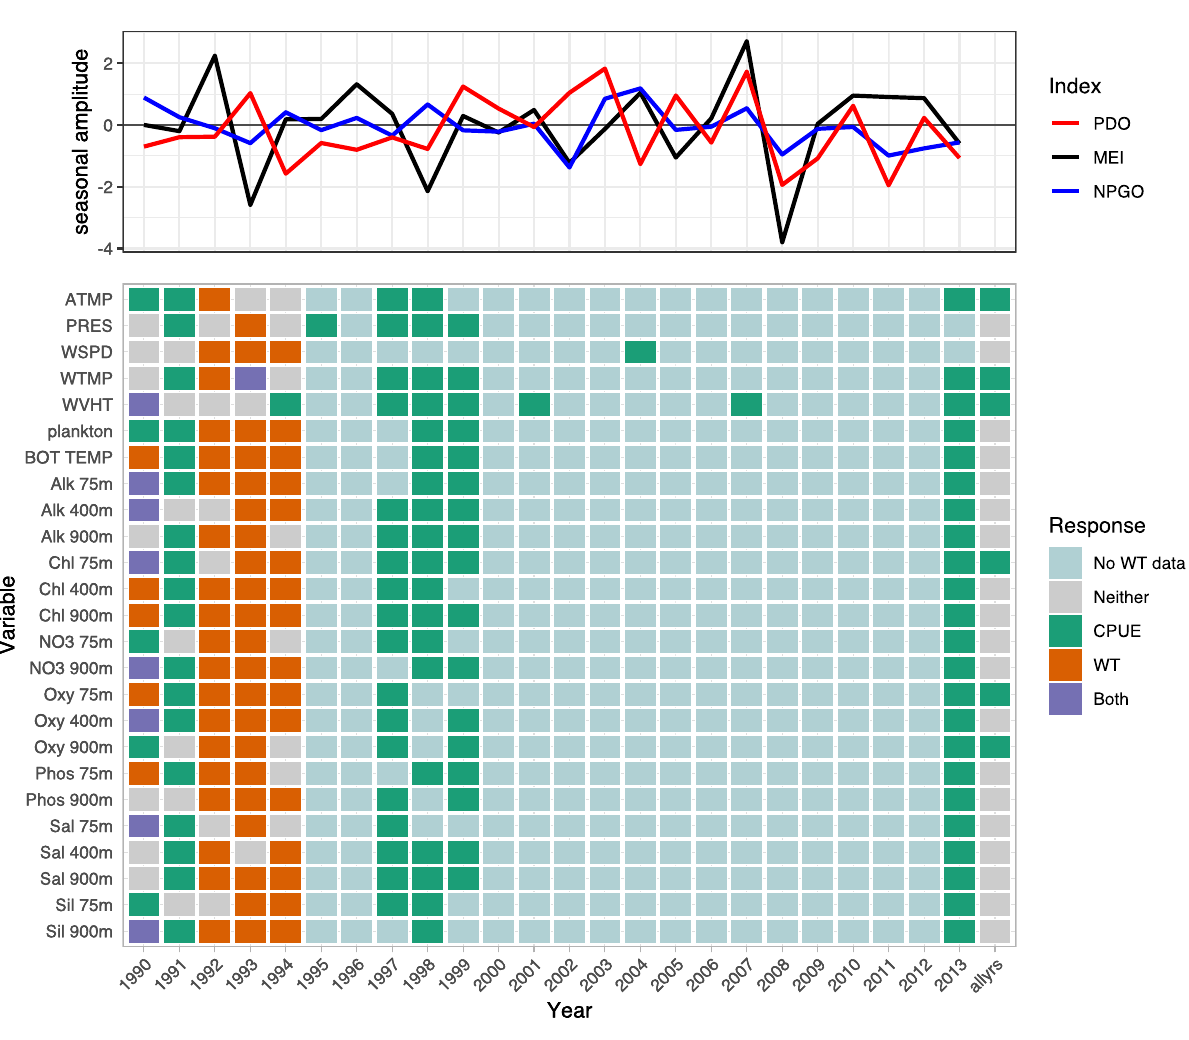
Figure 2. Variable selection analyzed for each available year and all years together for the SIVCMs with Pacific halibut CPUE or WT as the response. Axes, colors, and line plot are as described in Fig.